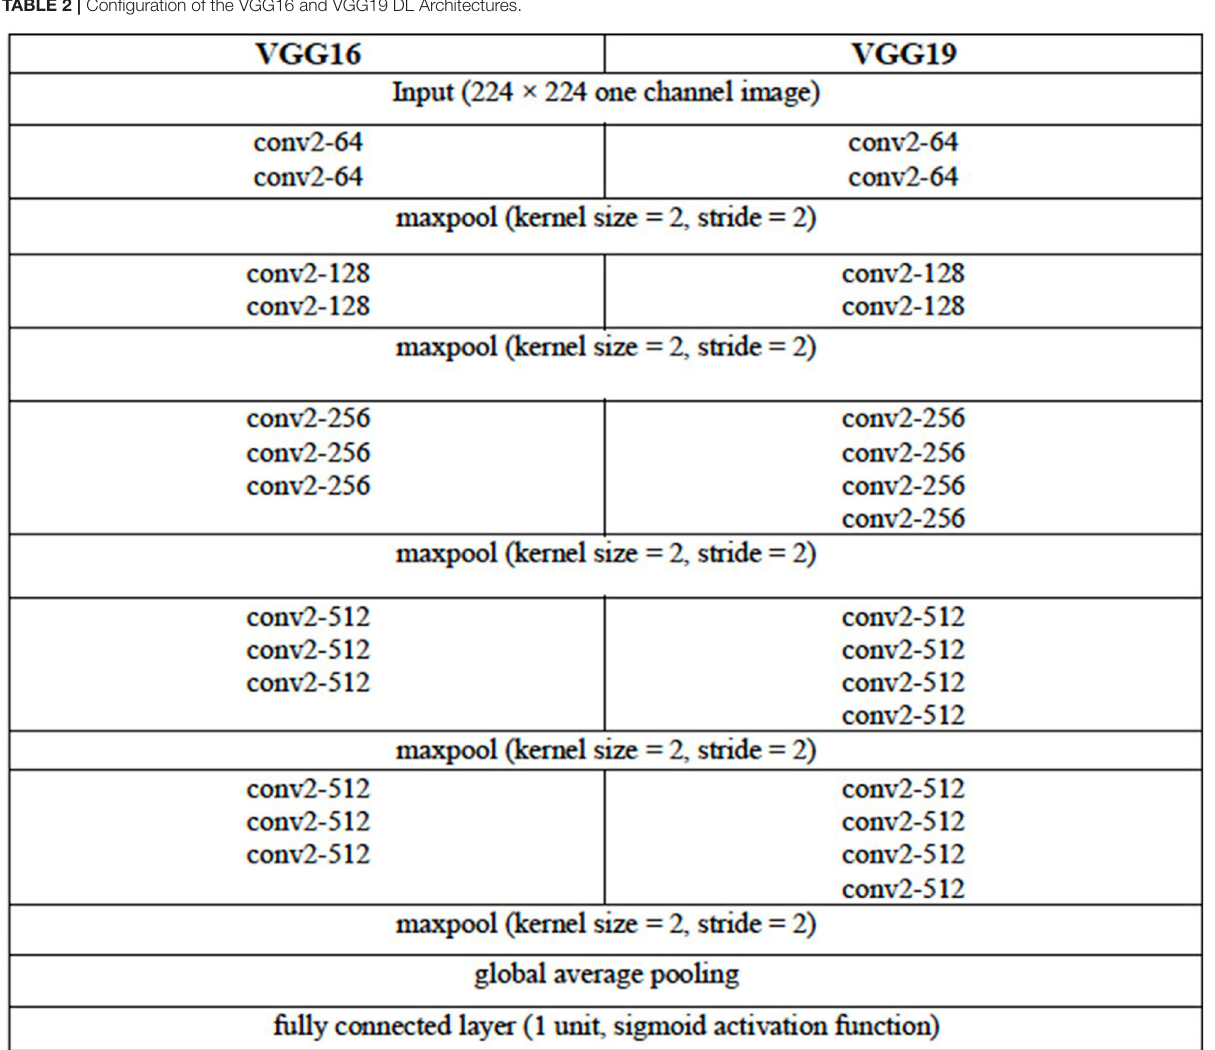
TABLE 2 | Configuration of the VGG16 and VGG19 DL